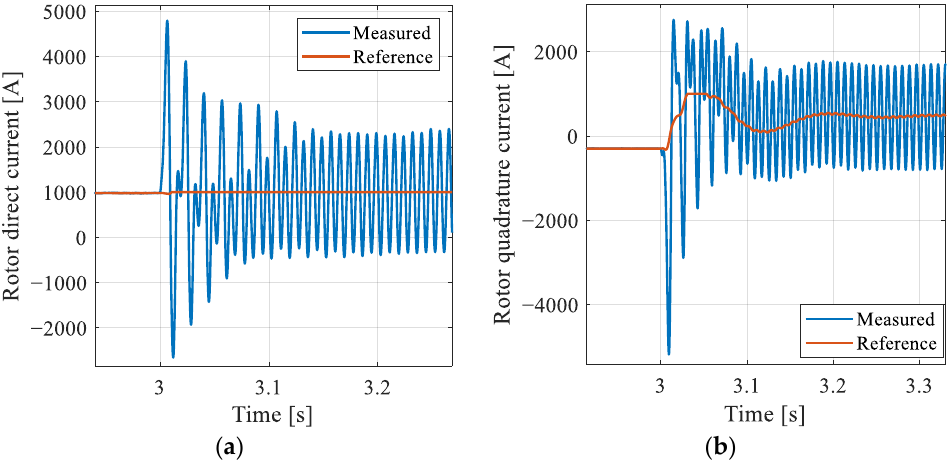
Figure 16. RSC currents for an unbalanced voltage sag of 20%: ( a ) d axis component and ( b ) q axis component.